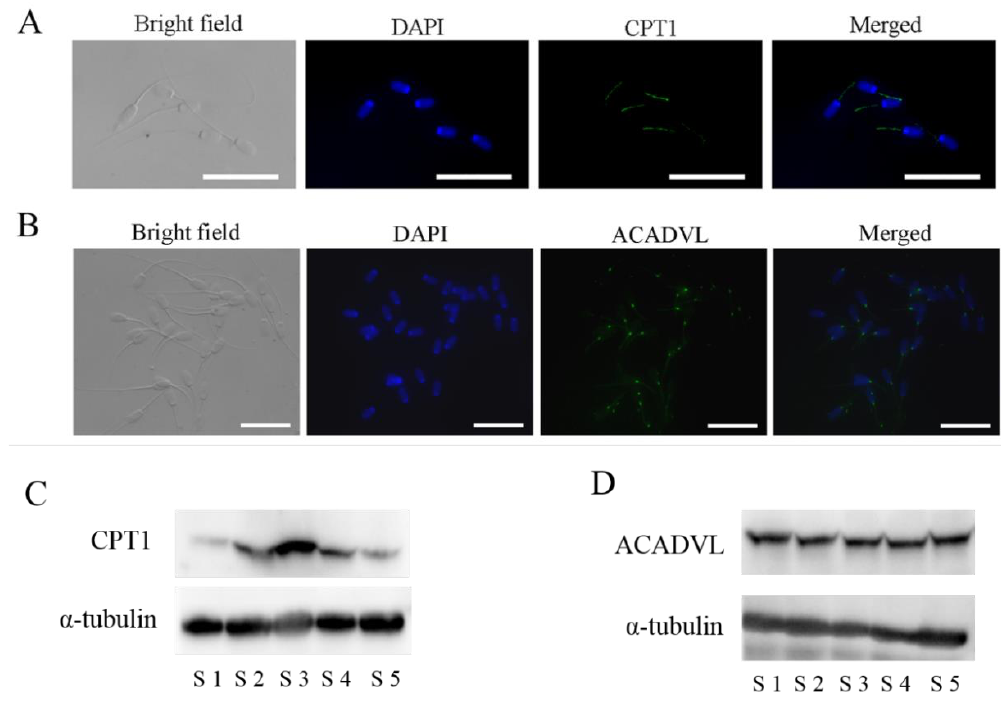
Figure 5. Detection and immunofluorescent localization of CPT1 ( A ) and ACADVL ( B ) in boar sperm. Western blotting analysis of CPT1 ( C ) and ACADVL ( D ) in fresh boar sperm. Bars = 30 µ m. CPT1: carnitine palmitoyltransferase 1. ACADVL: long-chain acyl-coenzyme A dehydrogenase. S1-S5: five different boar sperm samples.